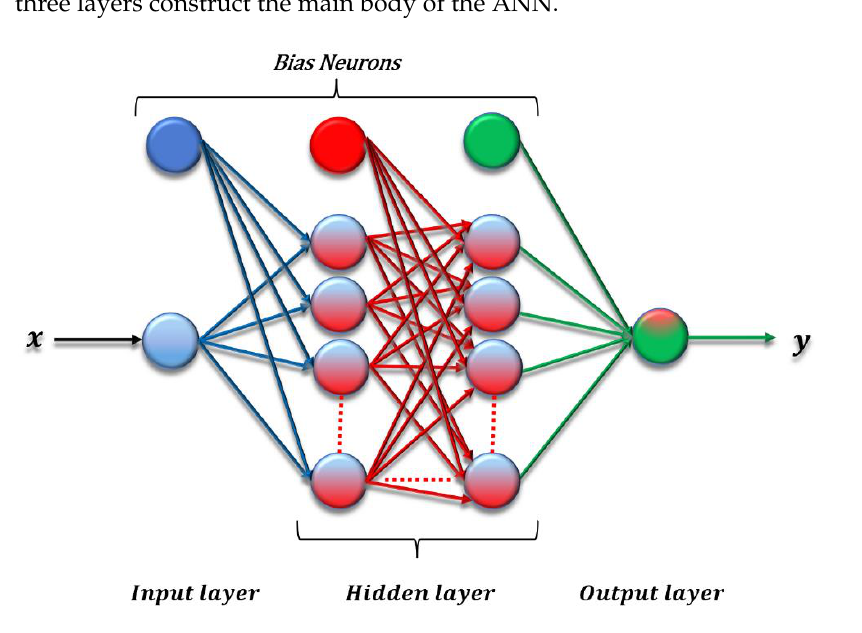
Figure 2. ANN structure.